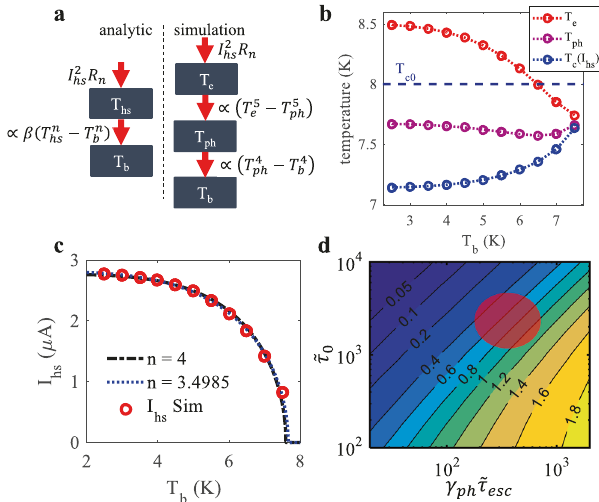
Fig.3|Electro-thermalsimulationsofhotspotsinsuperconductingnanowires. a Illustration of the conceptual difference between the analytic model, and numer- ical simulation. b Simulated electron ( T e ) and phonon ( T ph ) temperatures in the (cid:1) (cid:3) (cid:1) (cid:3) . c Simulated I hs T b (red centerof ahotspot, as afunctionof T b , along with T c I hs circles),alongwith fi tsusingEq.(3)with n =4(black),and n asfreeparameter(blue). d Heat map of β fit = β sim as a function of a characteristic electron-phonon coupling time( e τ 0 ),andascaledphononescapetime( γ ph e τ esc ).Theredellipseindicateswhere we expect the values for NbN to fall based on literature and our